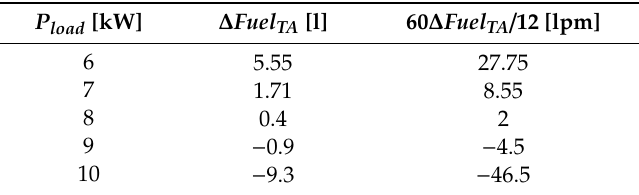
Table 4. The gaps in total fuel consumption for the Air-LFW and Fuel-LFW strategies (Case A and same P RES (cid:44) 0).